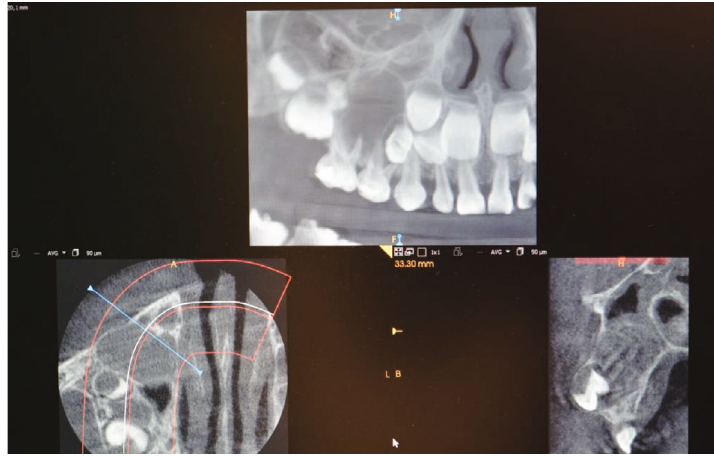
Figure 2: CBCT scans (GXDP-800, OP300-1, Gendex Dental Systems, 2017, Medical University of Lodz, Poland. Software: InVivoDentalViewer 5.1, Anatomage, Milan, Italy).